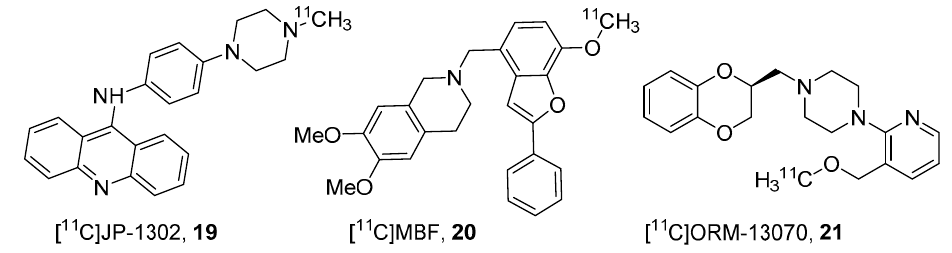
Figure 6. PET radiotracers for α 2C-ARs.